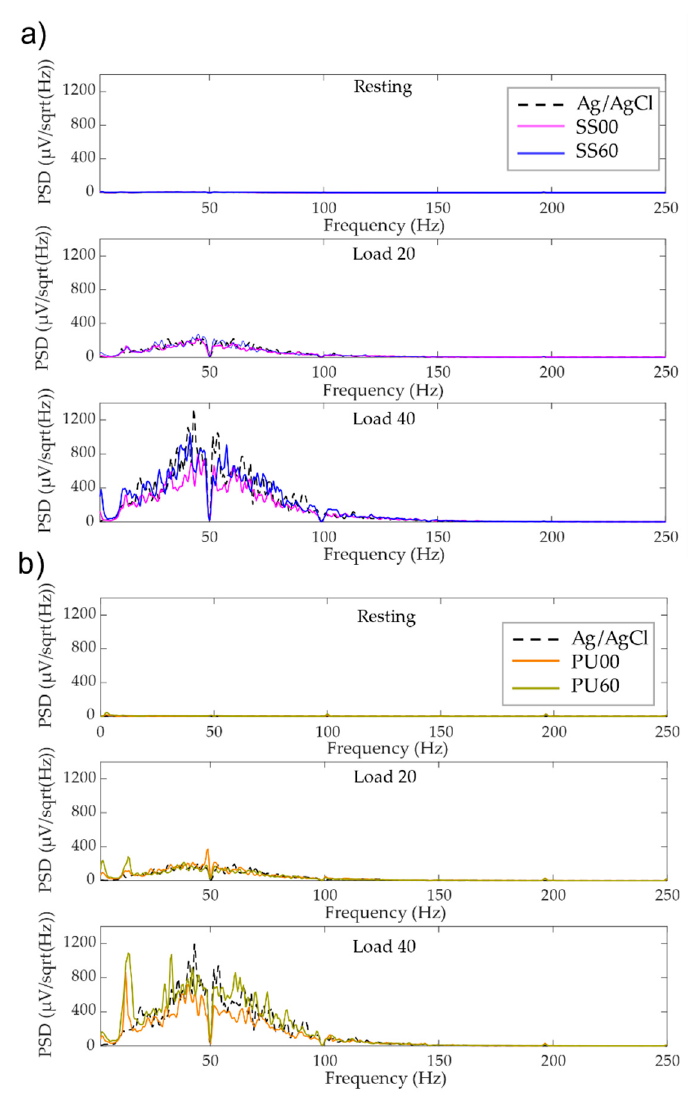
Figure 9. Power spectral density (PSD) grand average of the tested ( a ) stainless-steel (SS) and ( b ) thermoplastic polyurethane (TPU) electrodes and reference electrodes of the processed signal segments .